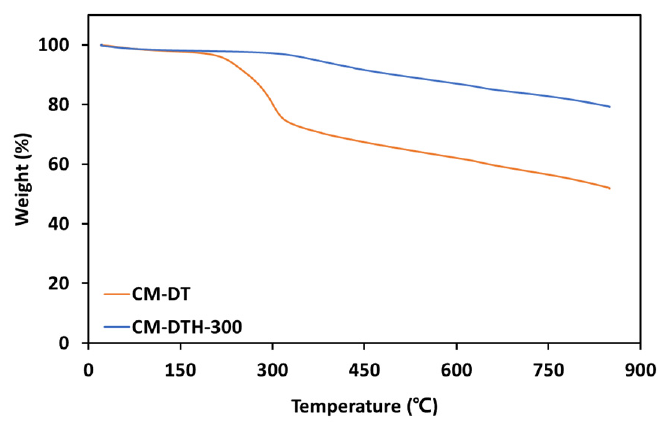
Figure 3. TGA thermograph for observation of heat treatment effect.